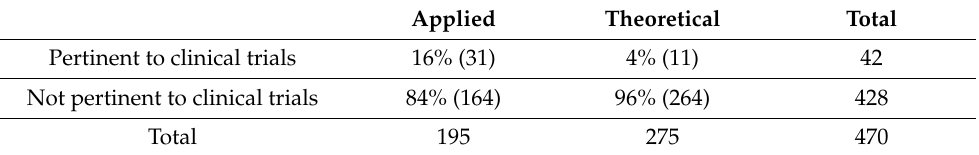
Table 3. Classification of articles according to LDA topics and pertinence to the clinical trial litera- ture.